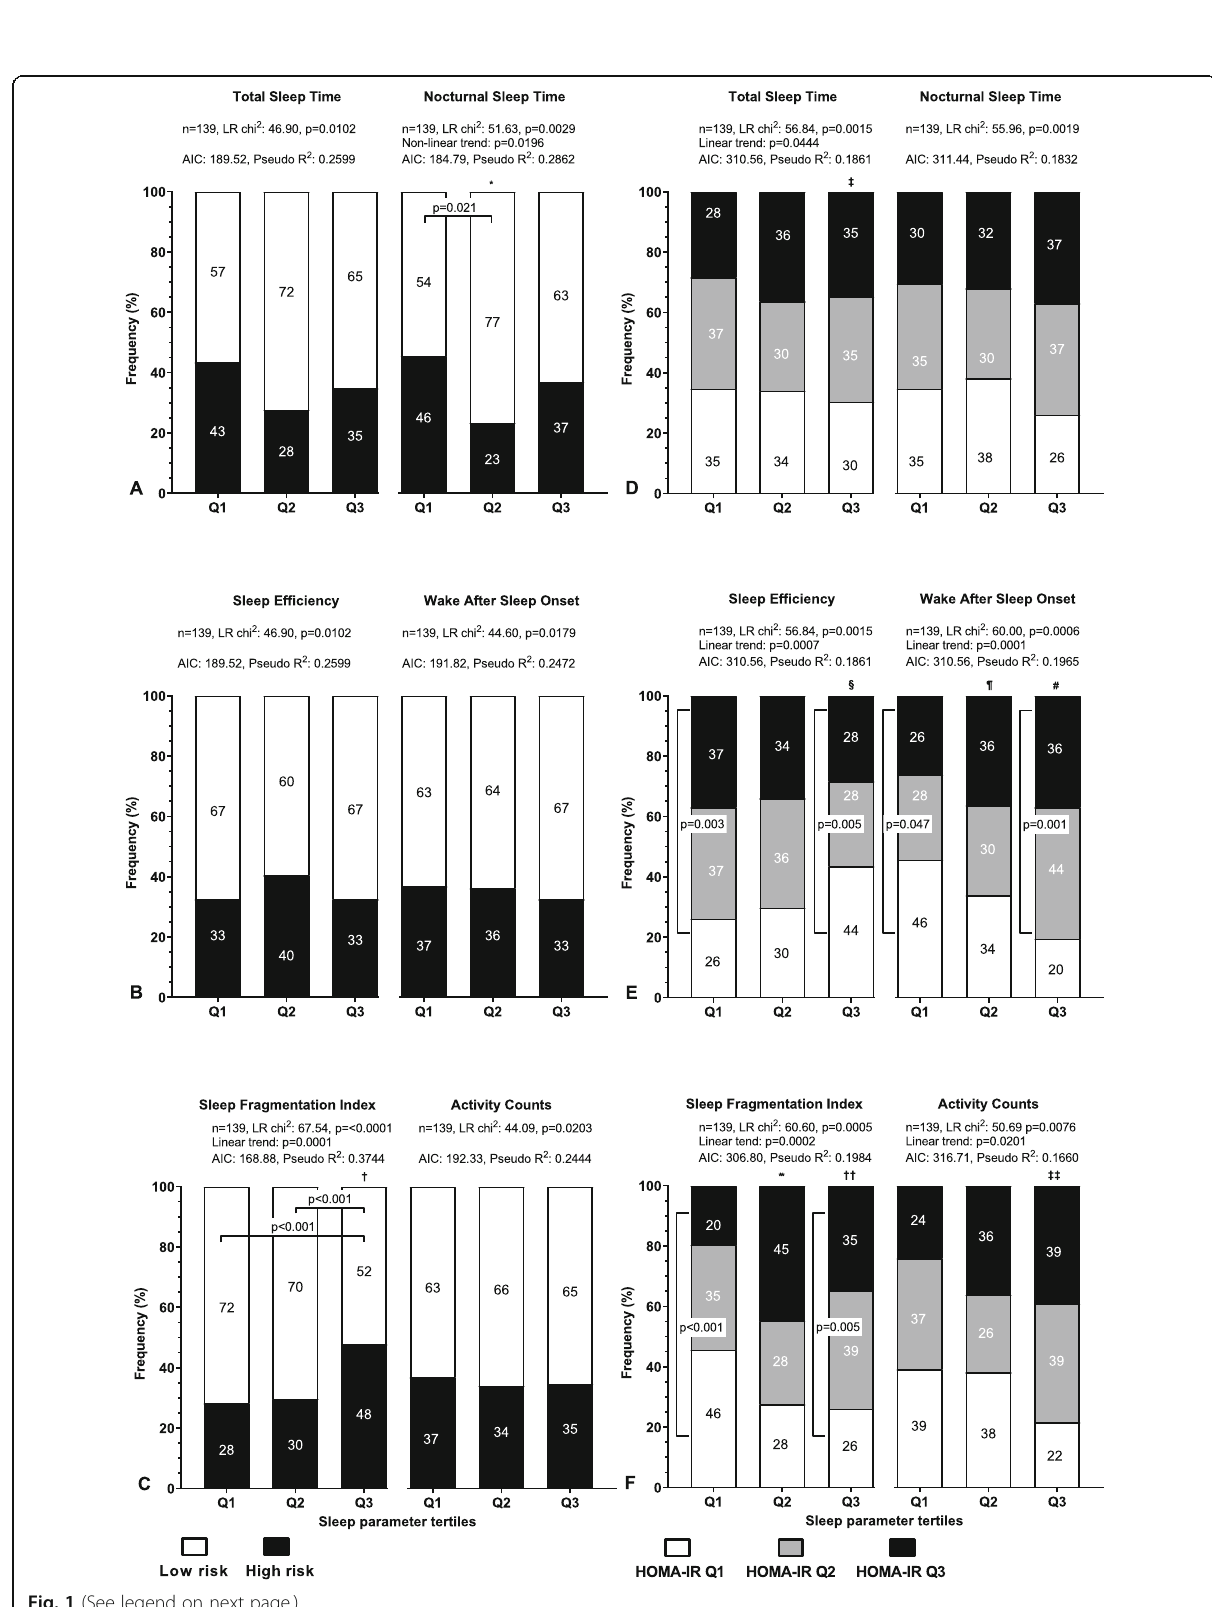
Fig. 1 (See legend on next